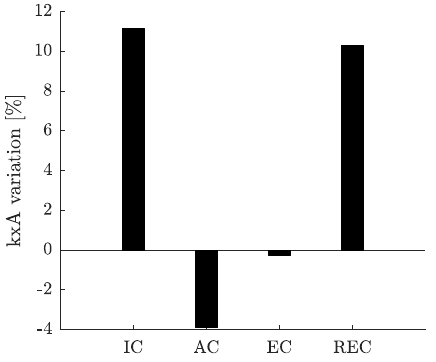
Figure 8. Variation of the k × A of the heat exchangers when varying the overall pressure ratio from 40 to 30 ( (cid:1827) (cid:2873)(cid:2872)(cid:2868) → (cid:1827) (cid:2873)(cid:2871)(cid:2868) )— ∆(cid:1846) (cid:3043)(cid:3046) = 5 K, (cid:2013) (cid:3010)(cid:3004) = 0.95 & (cid:2013) (cid:3002)(cid:3004) = 0.95 & (cid:2013) (cid:3006)(cid:3004) = 0.95 & (cid:2013) (cid:3019)(cid:3006)(cid:3004) = 0.9.